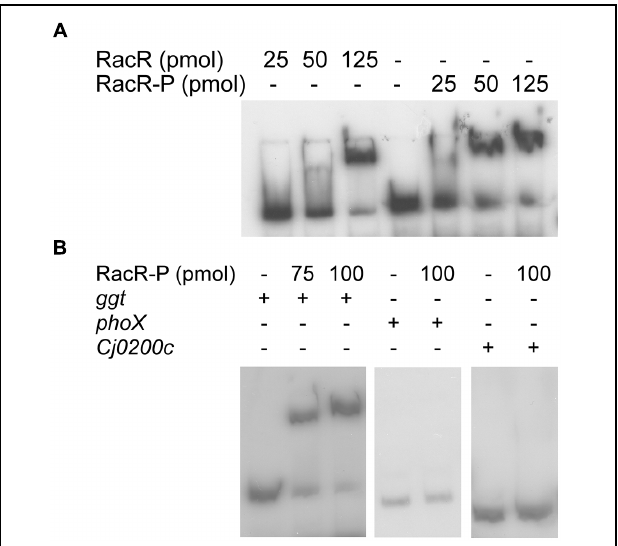
mutant indicating that this enzyme is solely responsible